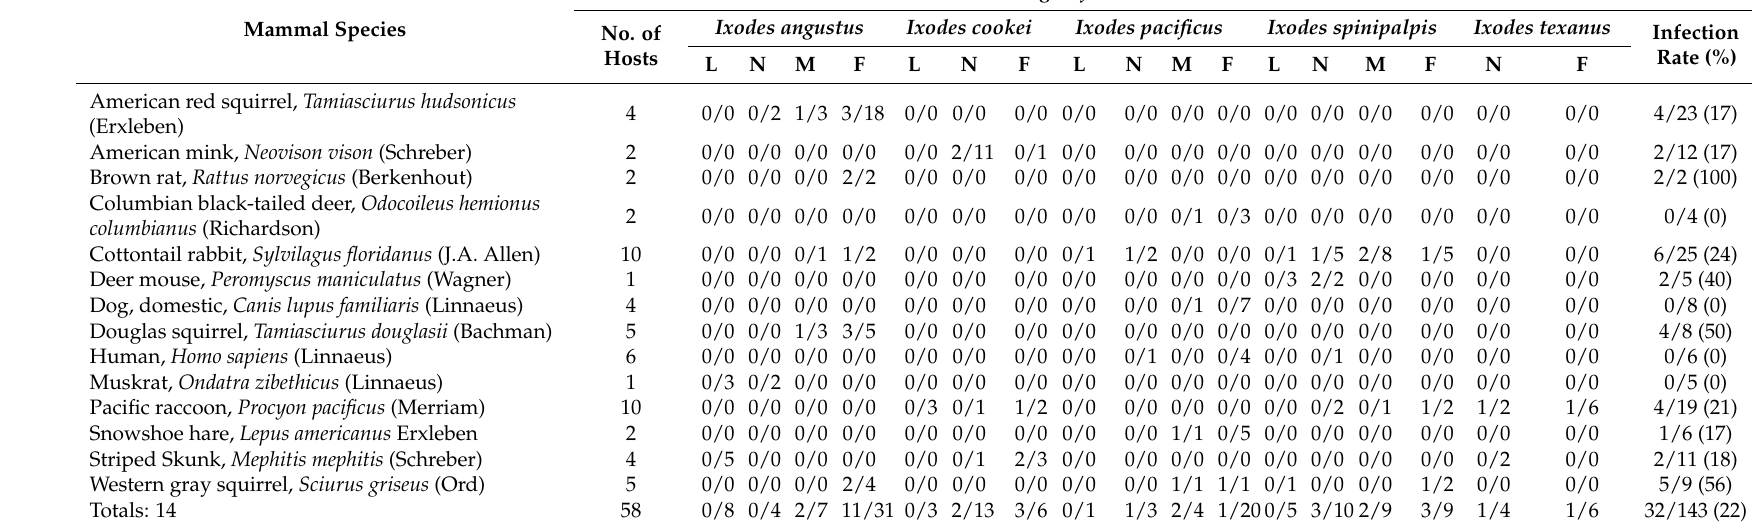
Table 3. Detection of Borrelia burgdorferi sensu lato in Ixodes ticks collected from mammalian hosts in the Metchosin-Victoria-Vancouver-Maple Ridge, British Columbia area,